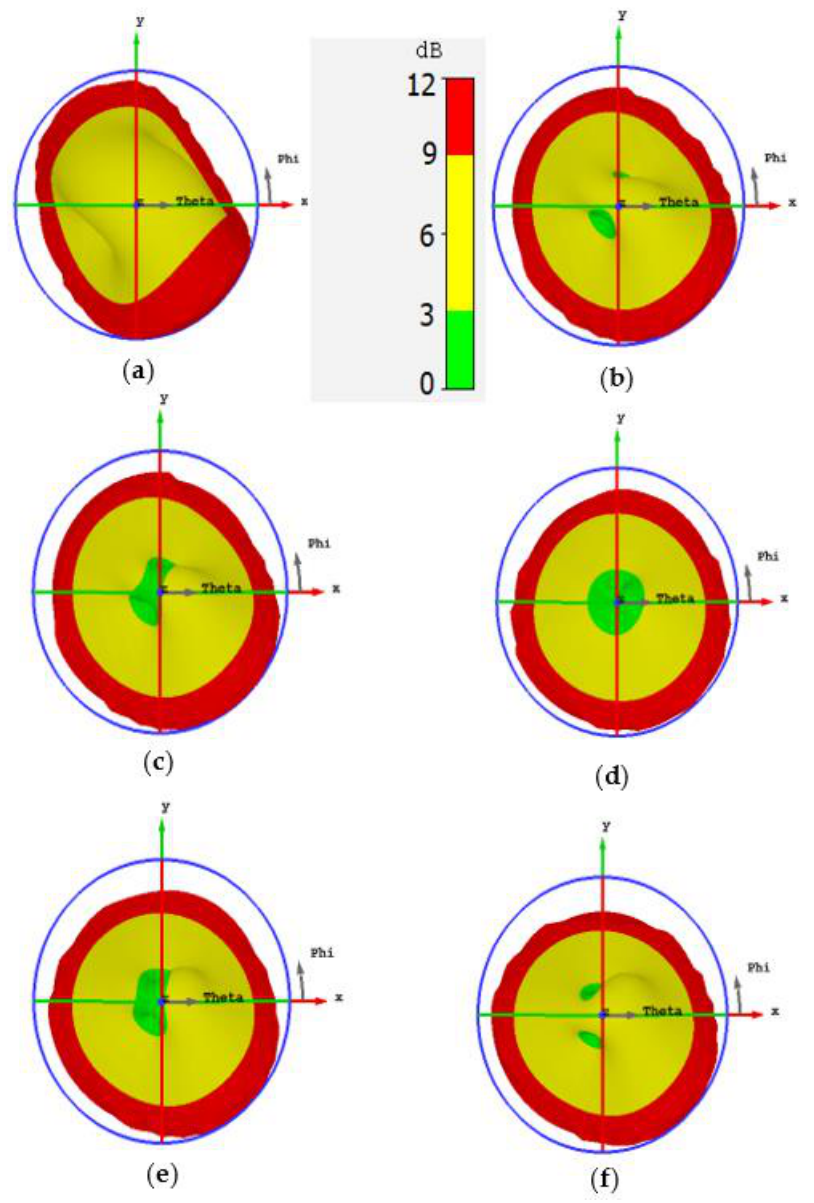
Figure 3. The axial ratio pattern of the proposed microstrip antenna for various values of slit width at 3.6 GHz using CST microwave Studio. ( a ) 𝑊 𝑠 = 0.5𝑚𝑚 ; ( b ) 𝑊 𝑠 = 1𝑚𝑚 ; ( c ) 𝑊 𝑠 = 1.5𝑚𝑚 ; ( d ) 𝑊 𝑠 = 2𝑚𝑚 ; ( e ) 𝑊 𝑠 = 2.5𝑚𝑚 ; ( f ) 𝑊 𝑠 = 3𝑚𝑚 .